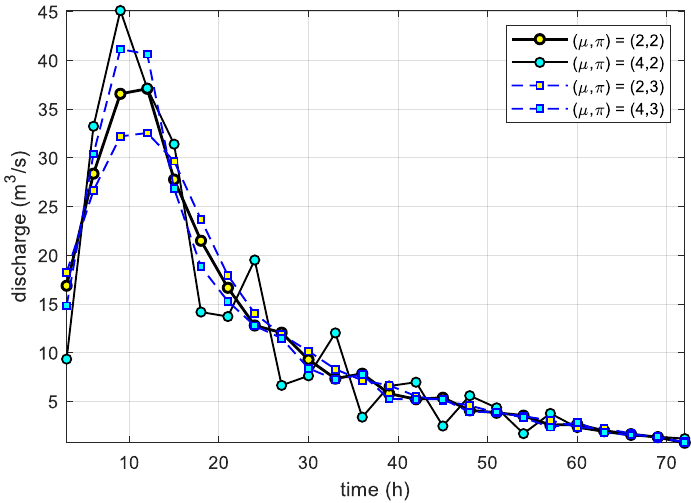
Figure 9. Effect on the instantaneous hydrographs due to variation of parameters of the Savitzky – Golay smoothing and differentiation filter. Table 1. Performance measure for selected Nenagh storm event with respect to four different parameter values of the SG filter.